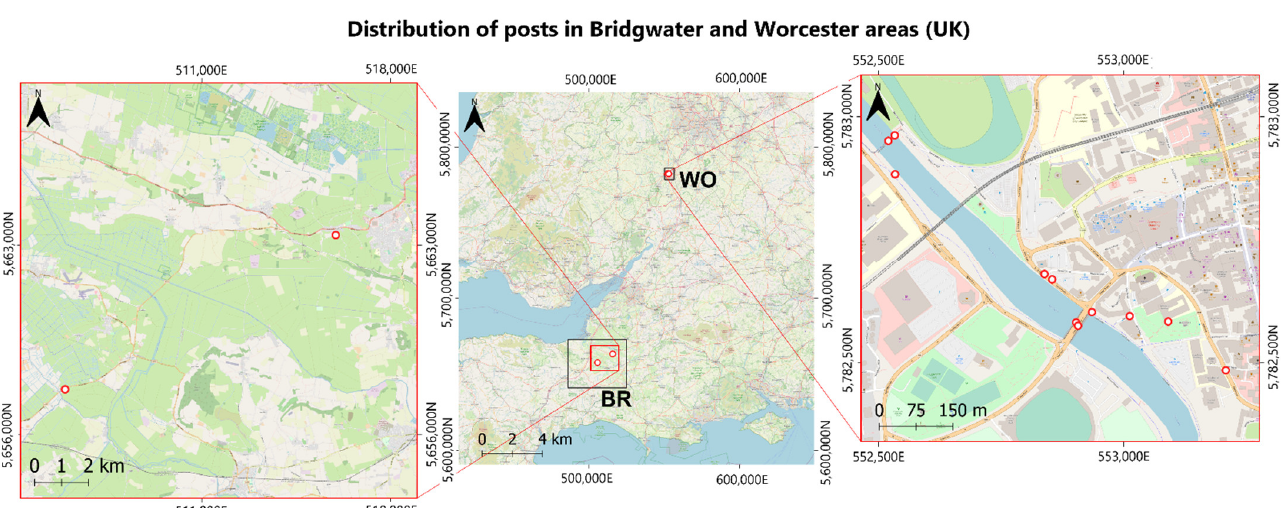
Figure 5. Distribution of posts used to build floodwater training samples for the Wilmington area (US). CRS: WGS84/UTM zone 18 N. Basemap data: OpenStreetMap contributors. 2.2.2. Satellite Imagery Satellite images were retrieved from the GloVis (Global Visualization Viewer) (https://glovis.usgs.gov/, last access 1 October 2022). Satellite missions and single acquisitions were selected by considering social media data availability and cloud cover percentage. Specifically, the acquisition date of satellite images should be as close as possible to that of social media posts. Moreover, cloud coverage should be as limited as possible (<10%). Given these restrictions, a single Landsat-7 image acquired on 16th